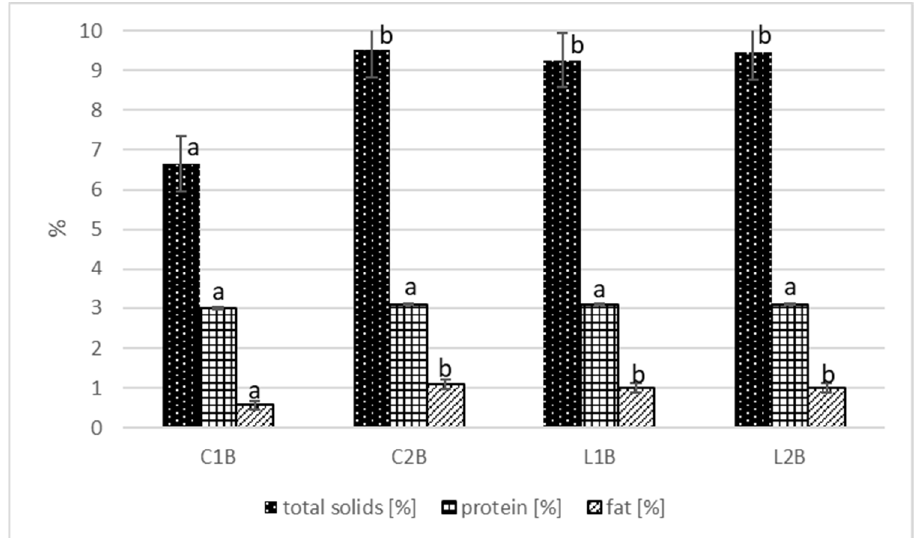
Figure 2. Total solids, protein and fat content of tested buttermilk. C1B—commercial buttermilk 1; C2B—commercial buttermilk 2; L1B—laboratory buttermilk with MO 242 culture; L2B—laboratory buttermilk with MSO culture. Different letters indicate statistically significant differences ( p < 0.05) between mean values.